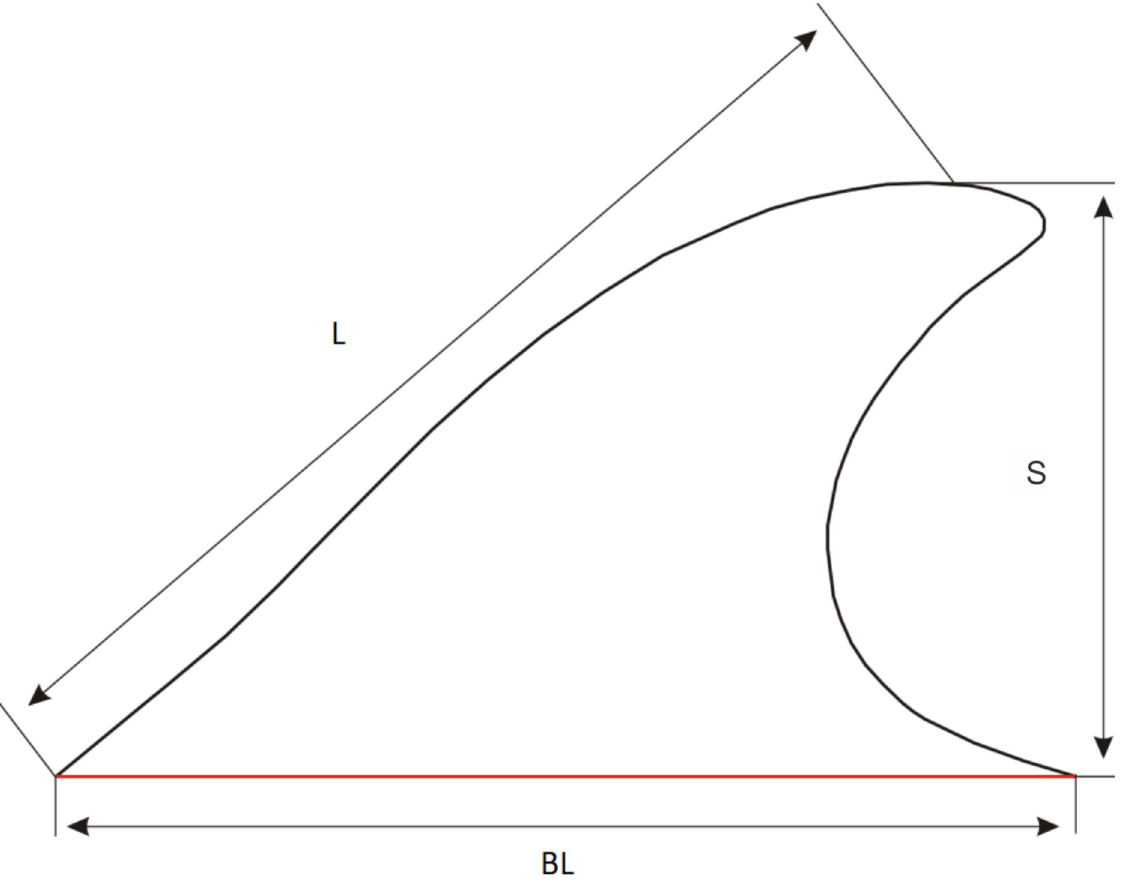
Fig 3. Basic measurements of